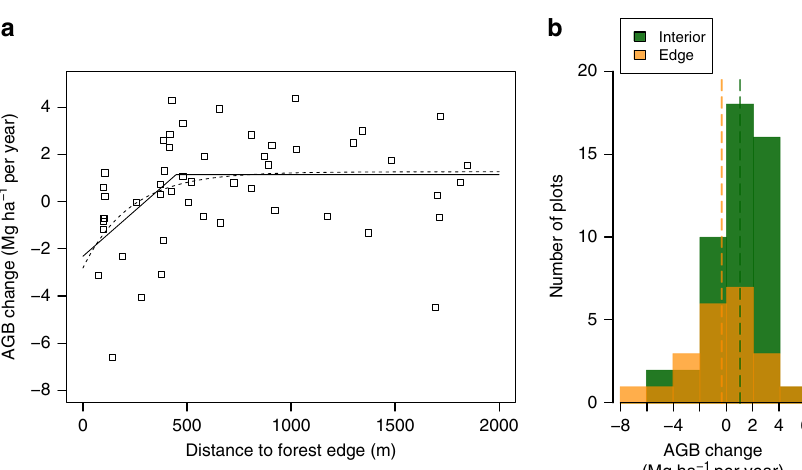
Fig. 2 Anthropogenic edge impact on plot above-ground live biomass change in structurally intact forests of Borneo. a A hockey-stick model (solid line; break-point at 448 m, 1.14 Mg ha − 1 per year) and asymptotic model (dashed line, asymptote 1.26 Mg ha − 1 per year) showing saturating edge effect on AGB change. b Histograms of plot AGB change, weighted by the cube root of monitoring length, in forest interior ( ≥ 448 m, n = 49; mean 1.01 Mg ha − 1 per year, green dashed line) and edge plots ( < 448 m, n = 22; mean − 0.36 Mg ha − 1 per year, orange dashed